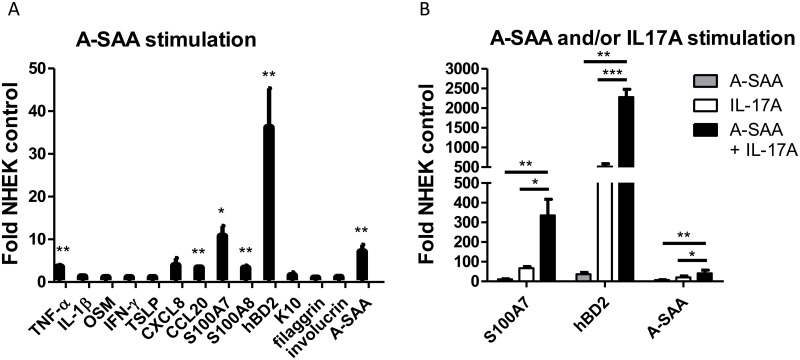
Expression of proinflammatory mediators by A-SAA-stimulated NHEK and in synergy with IL-17A.(A) NHEK were incubated with A-SAA (10 μg/ml) for 24 hours and the expression of TNF-α, S100A7, S100A8, hBD2, CCL20 and A-SAA was determined by RT-qPCR. (B) IL-17A (10 ng/ml) had a synergistic effect with rA-SAA. After A-SAA and IL-17A costimulation, mRNA expression of S100A7, hBD2 and A-SAA were further increased compared to A-SAA or IL-17A alone. Three independent experiments with duplicates were performed. Values are expressed as mean ± SEM fold change above unstimulated NHEK. Statistical comparisons were performed using t test (*p<0.05; **p<0.01; ***p<0.001).